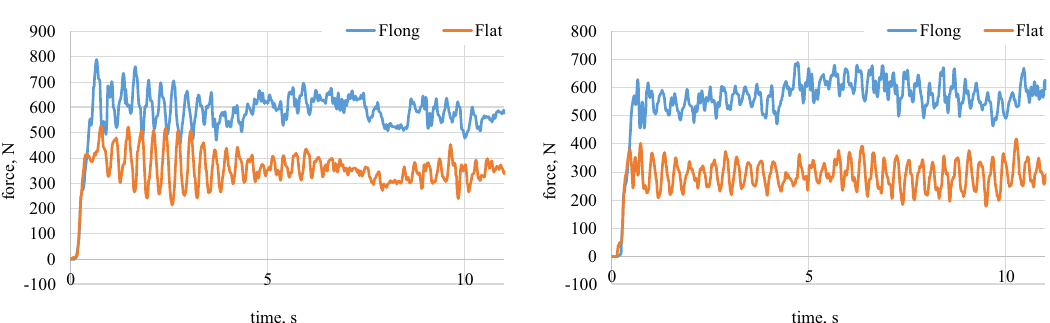
Figure 8. Longitudinal and lateral forces related to the wheel geometry for α w = 60°. On the left waveform raw data for dry granite; on the right waveform raw data for the wet